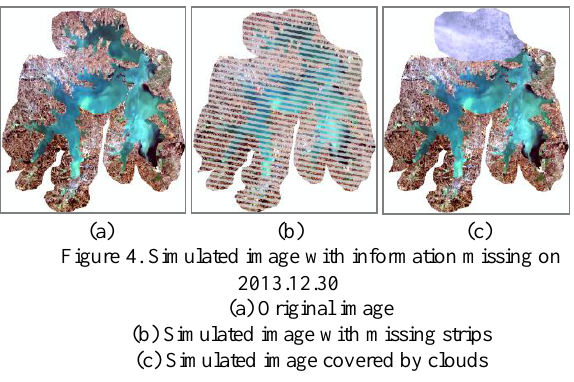
4.2 Results of the water body extraction from TM images with missing